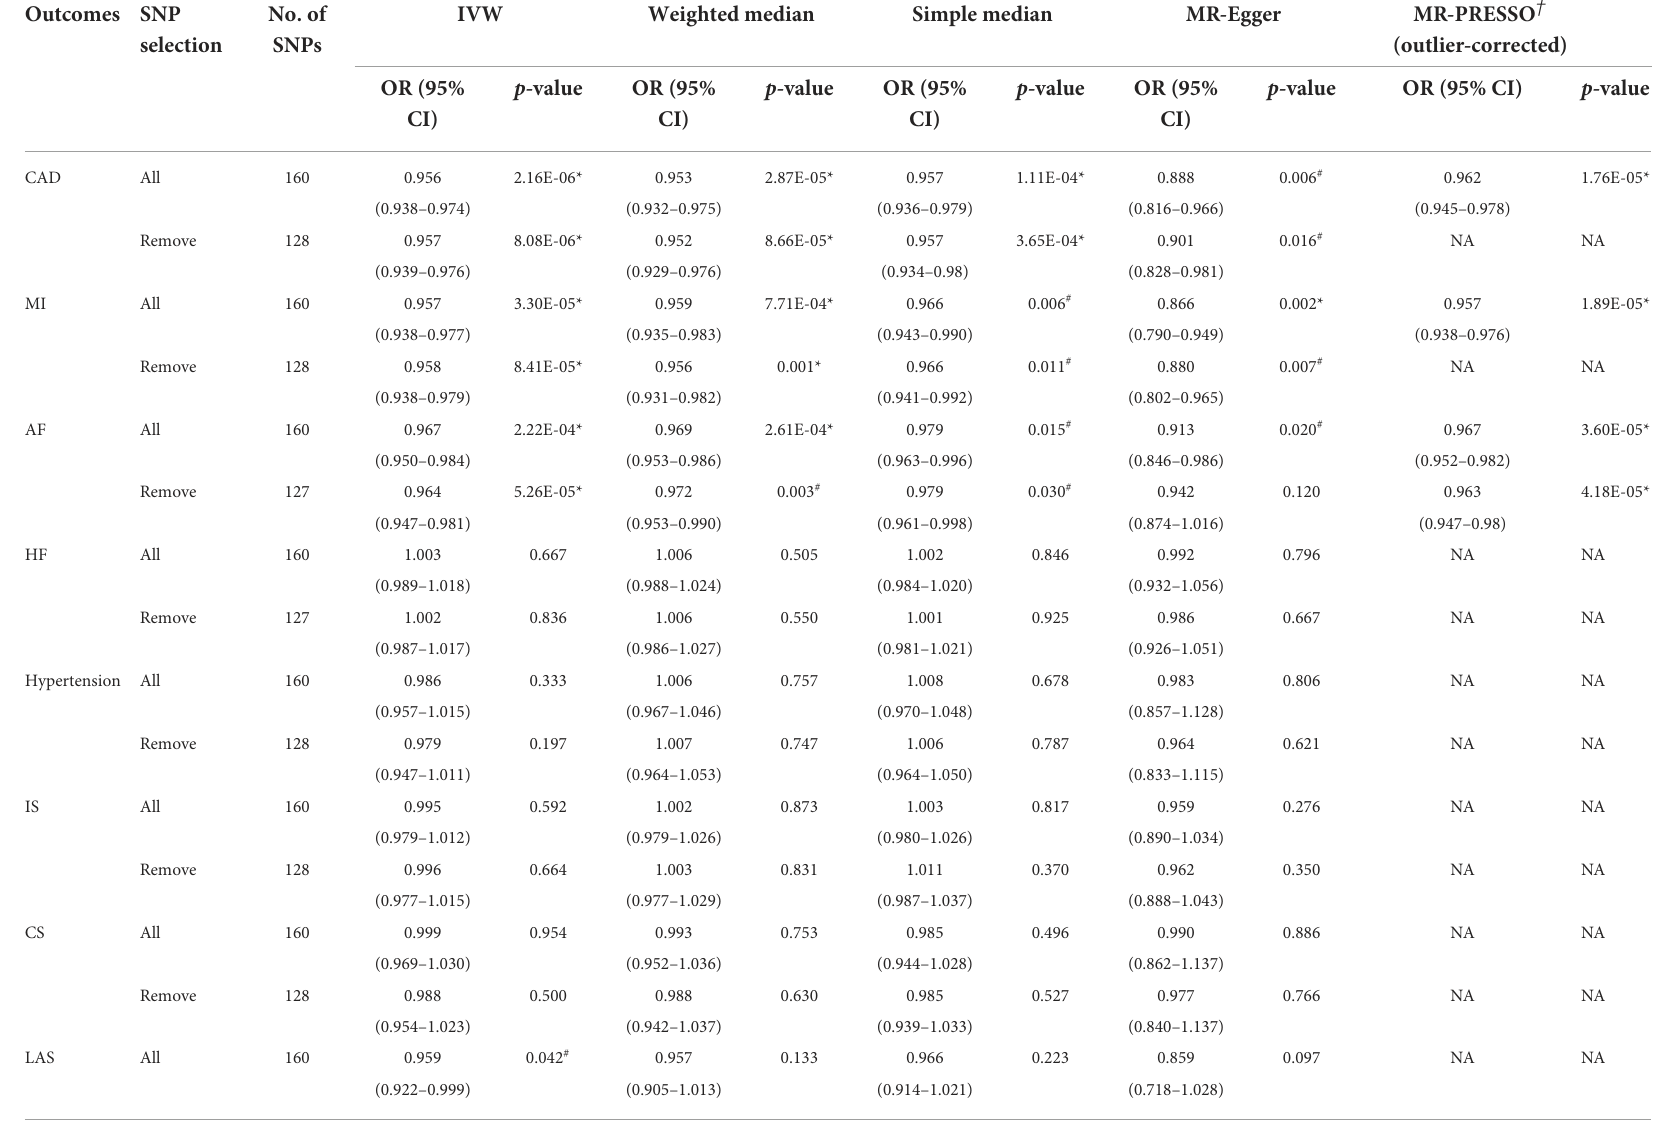
TABLE 1 Mendelian randomization estimates between right handgrip strength and cardiovascular